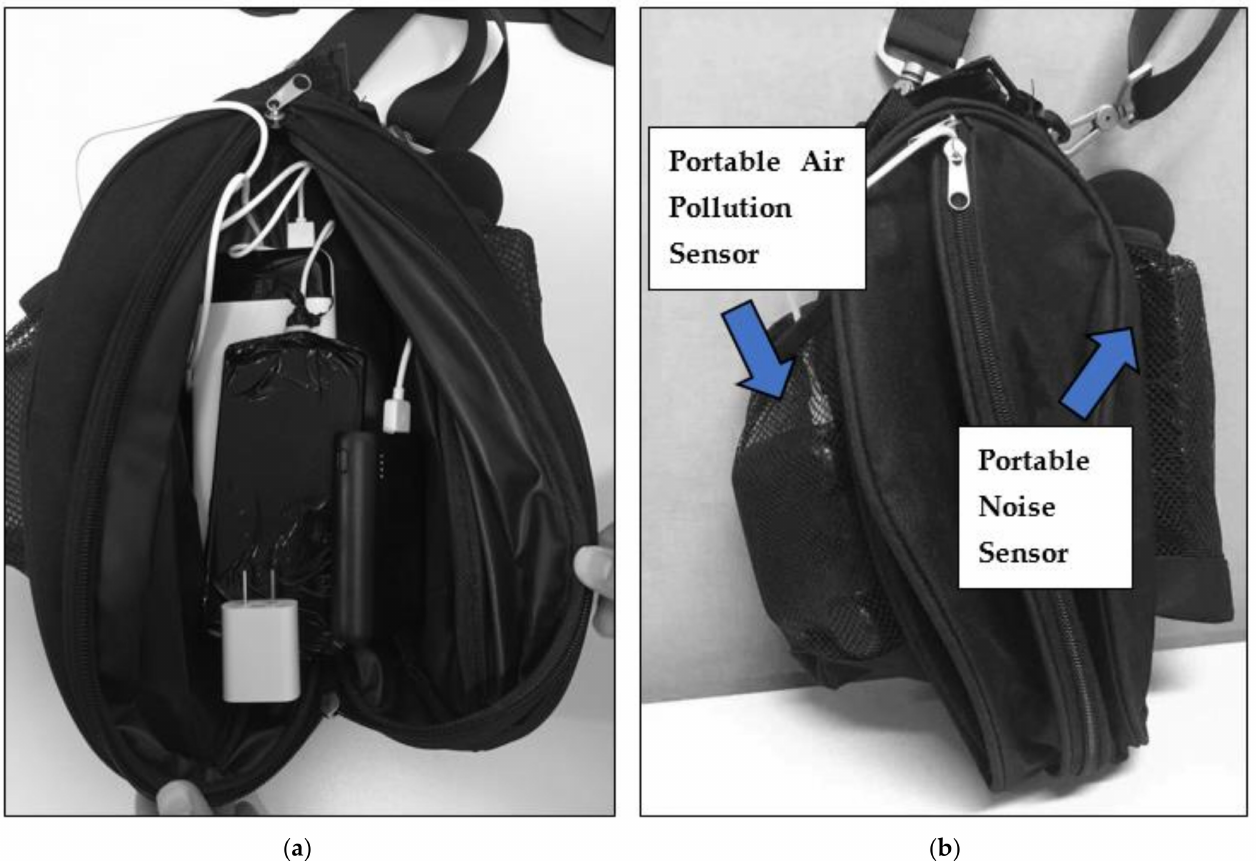
Figure 3. The device bag for the GPS and mobile sensors. ( a ) The portable devices are packed into a device bag; ( b ) air pollution sensors and noise sensors are placed in the two external mesh pockets on the two sides of the